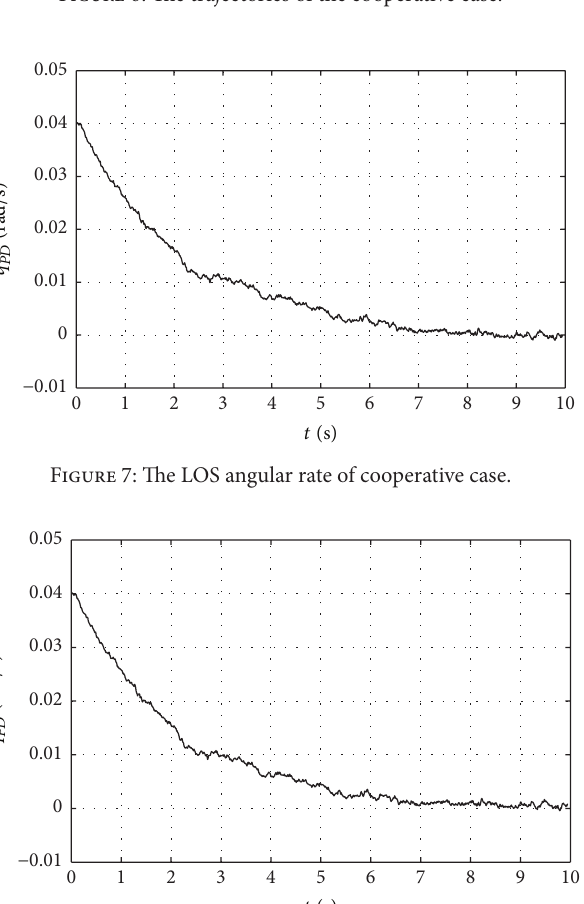
Figure 6: The trajectories of the cooperative case.